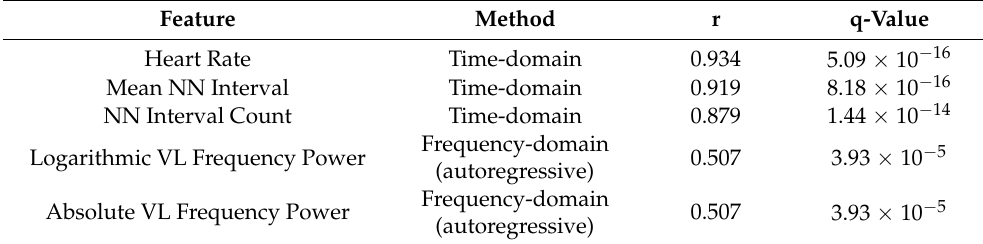
Table 4. Top five features according to the Kendall correlation